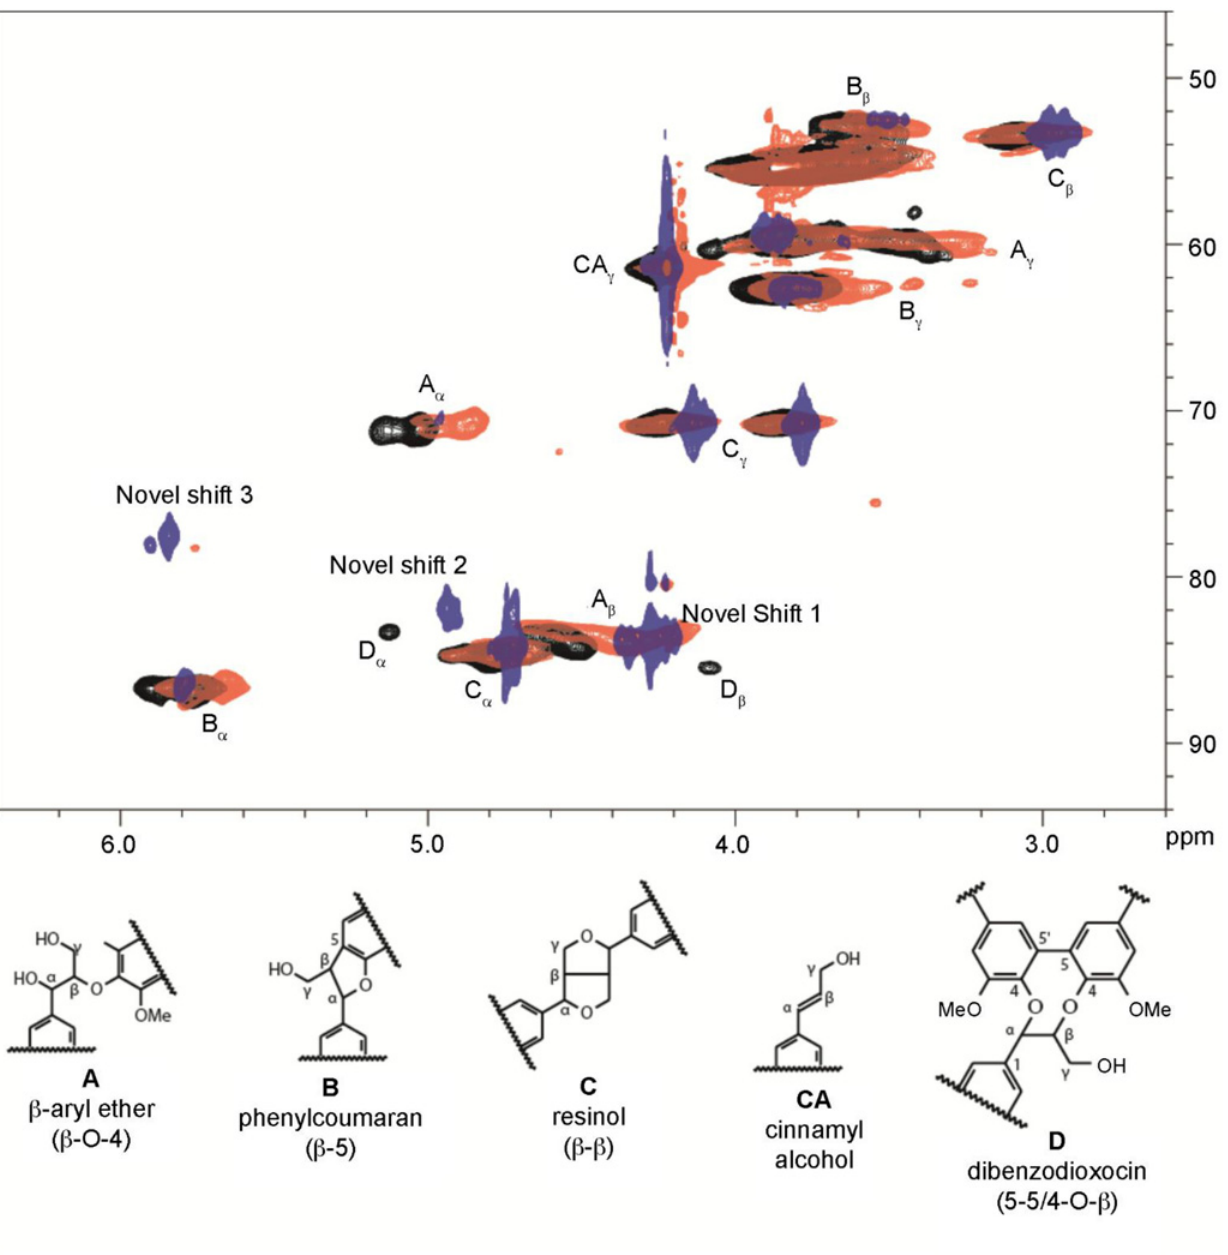
Fig 2. NMR spectra of the DHPs. The aliphatic regions of the HSQC 2D-NMR spectra of 100% coniferyl alcohol DHP (G-DHP, black), copolymer of 25% 3-EPC, 6 and coniferyl alcohol, 7 (red), and 100% 3-EPC, 6 DHP (blue).